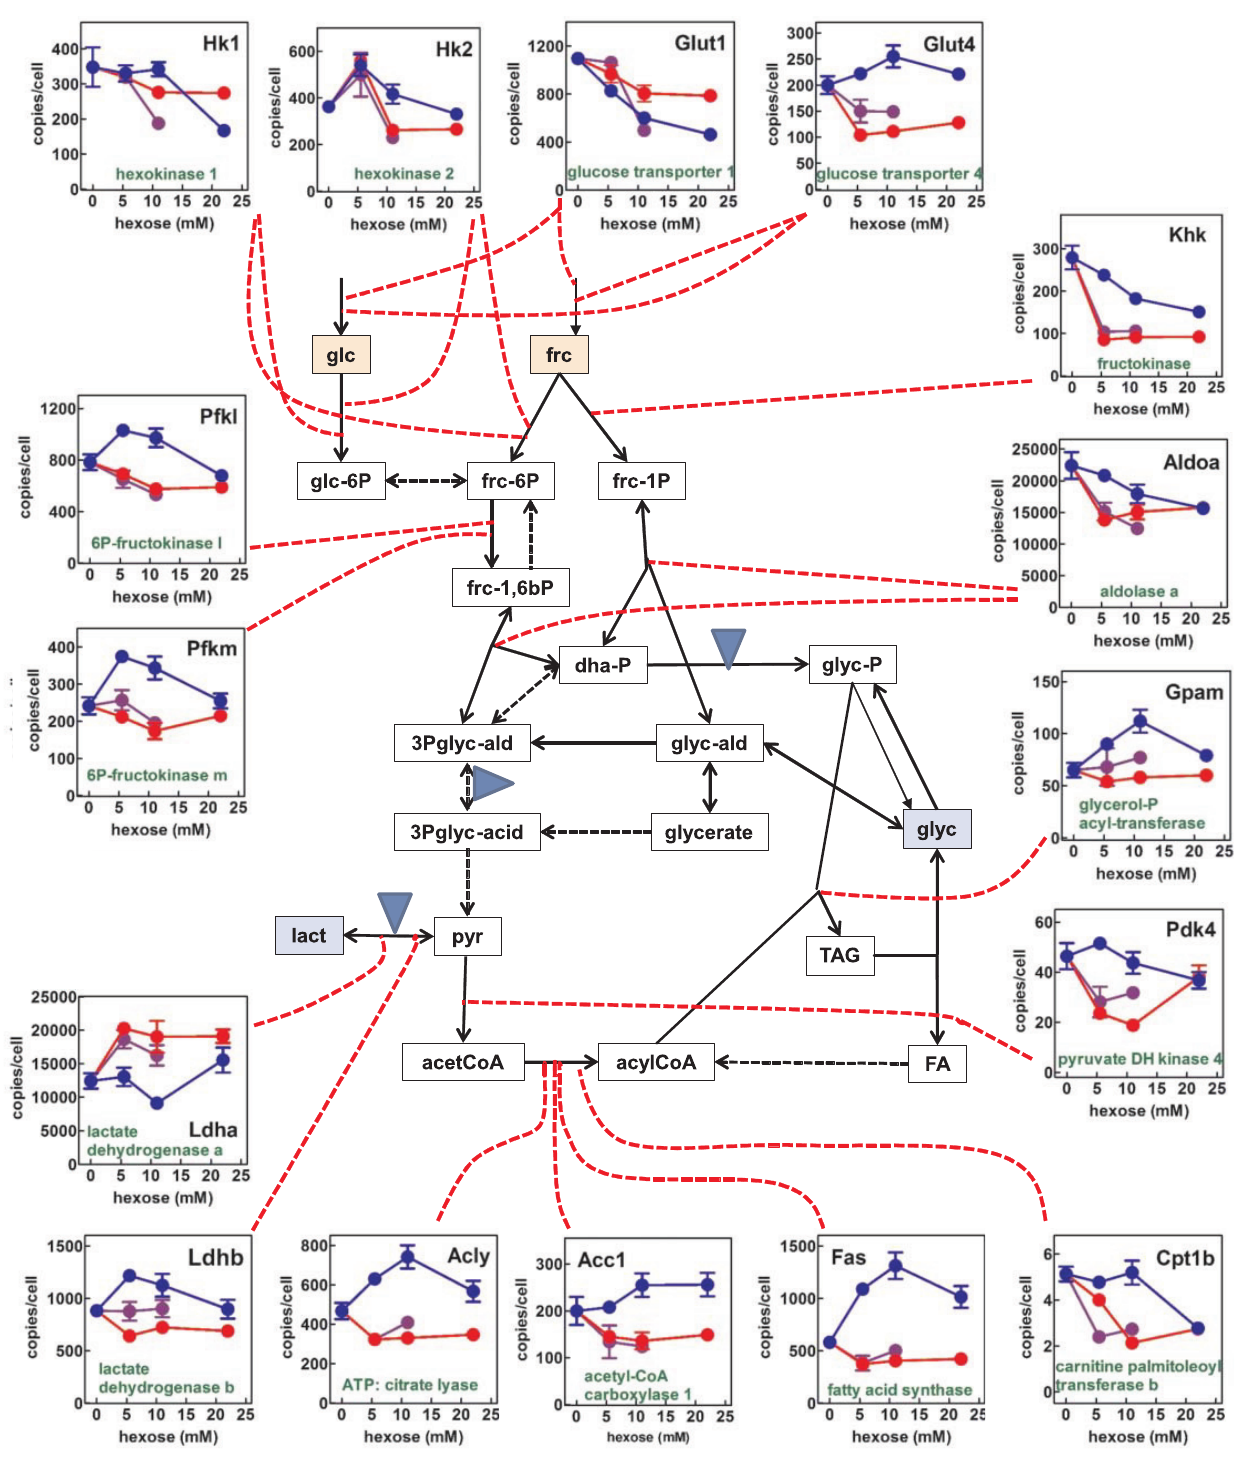
Fig 4. Gene expression of enzymes of glucose/ fructose metabolism and triacylglycerol synthesis in 3T3-L1 adipocytes exposed to a medium with varying concentrations of glucose, fructose or a combination of both. Solid lines represent the paths analyzed in this Fig and in Fig 4; blue triangles indicate the sites of production and utilization of NADH. The graphs indicate the number of copies of specific mRNAs for the genes (in black) corresponding to the enzymes and transporters (in green) acting on the corresponding paths (linked by red dotted lines). In each graph, the expressions in the presence of glucose are marked in blue, and those with fructose in red. The mixed-hexose groups are marked in purple. Each point corresponds to the mean ± sem of